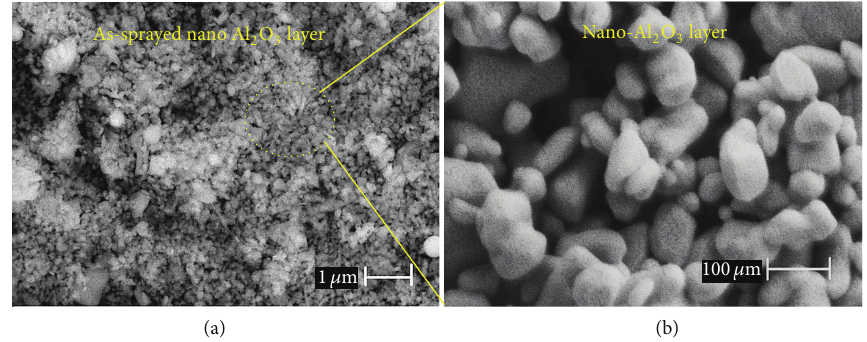
Figure 7: FESEM images of surface of the as-sprayed nanostructured Al 2 O 3 layer made from ultrafine particles: (a) × 5.0K and (b) ×